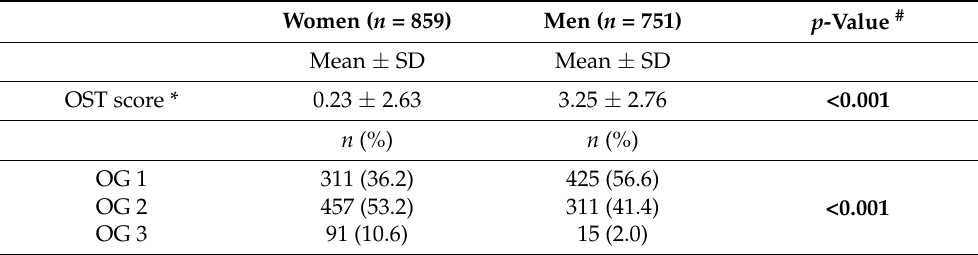
Table 2. Osteoporosis status of participants by sex.